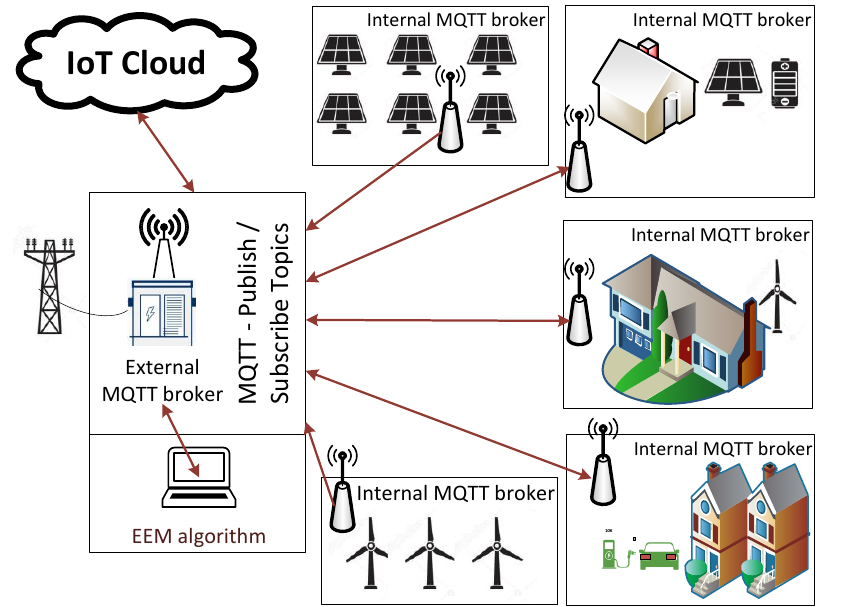
Figure 2. Proposed hierarchical control